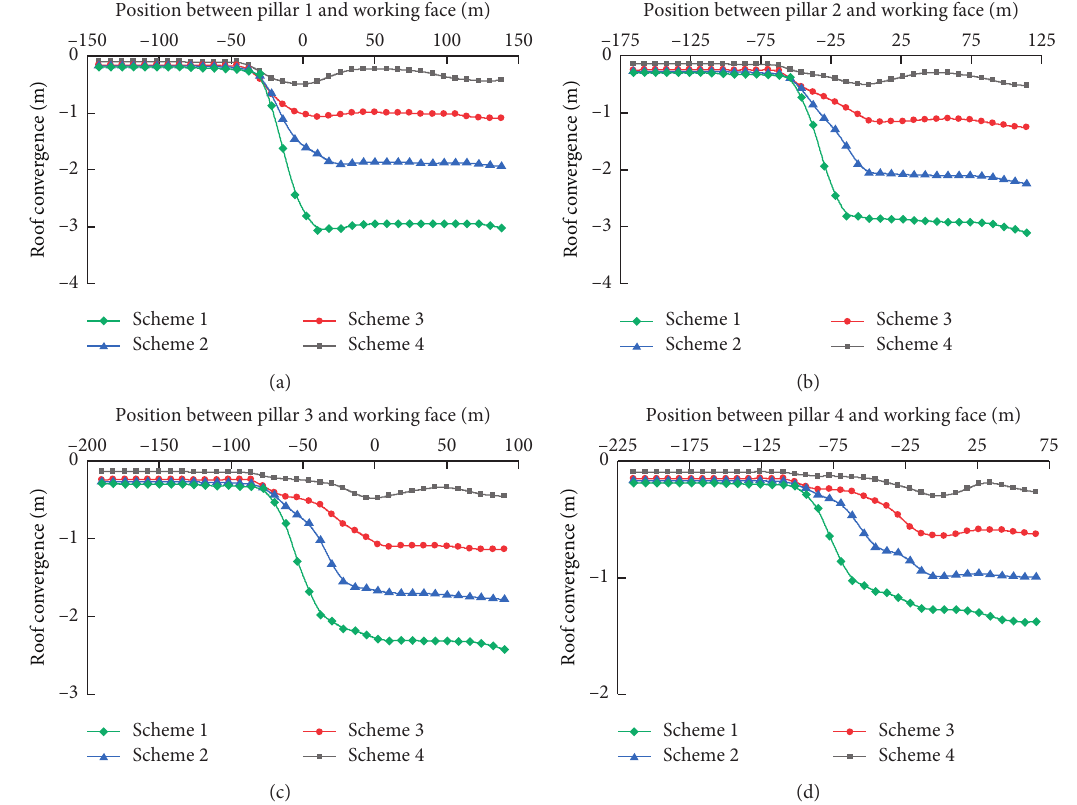
Figure 10: Roof convergence above the studied coal pillars using different UZHUG